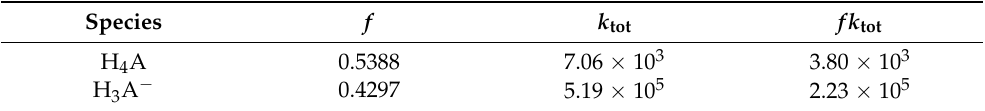
Table 5. Molar Fractions ( f ), total rate constant ( k tot in M − 1 s − 1 ) and fraction corrected total rate constant ( fk tot in M − 1 s − 1 ), at 298.15 K in aqueous solution at pH = 7.4, for the reaction between scutellarein species and